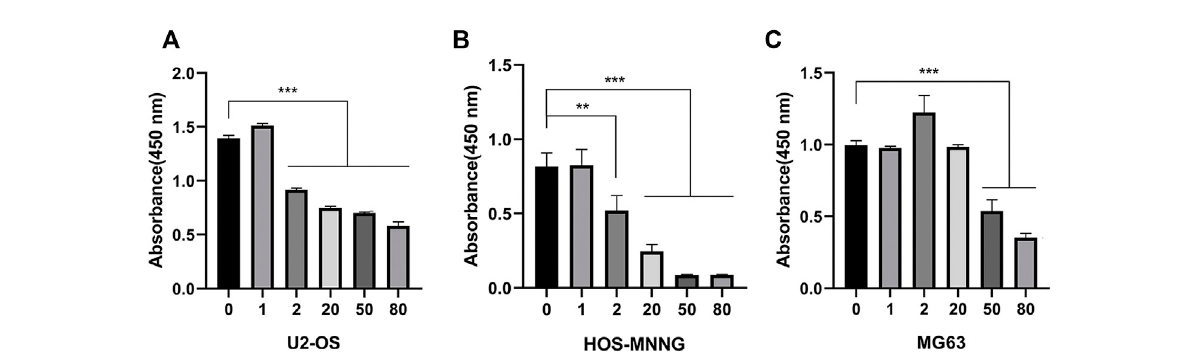
FIGURE 1 Zoledronic acid inhibits the growth of osteosarcoma cells. U2-OS (A) , HOS-MNNG (B) and MG63 (C) were treated with 0, 1, 2, 20, 50, 80 μ M zoledronic acid for 3 days, respectively. The viable cells were detected by CCK8 reagent. The means ± SEM are indicated, n = 3. ** p < 0.01, *** p <